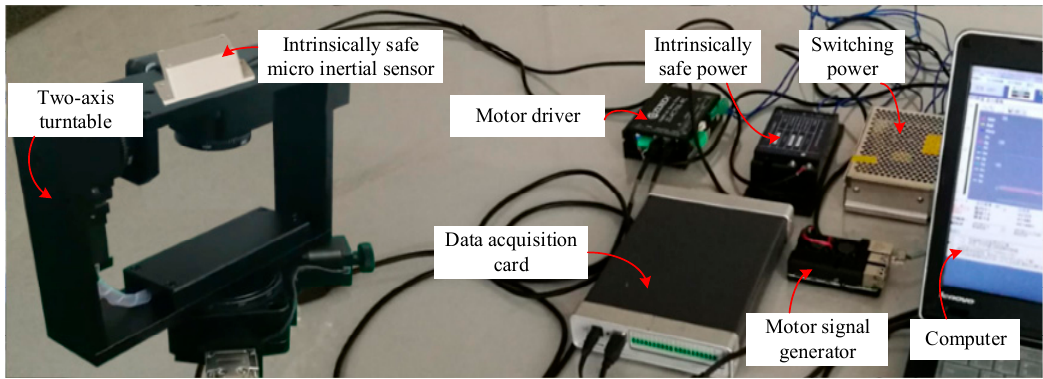
Figure 5. The experimental platform for testing the support attitude sensing system.